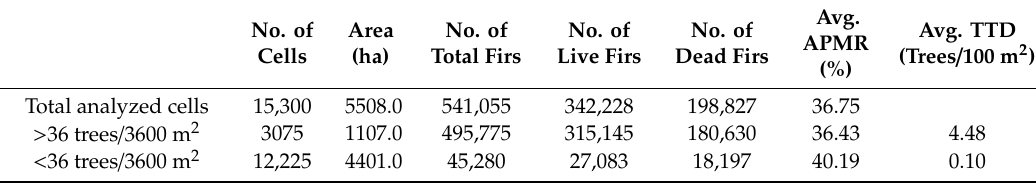
Table 1. Distribution status of Korean fir in the study